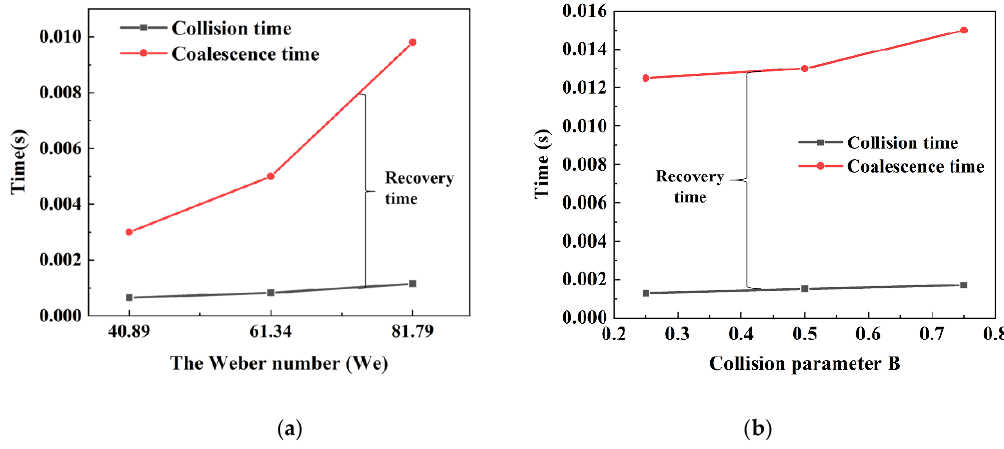
Figure 11. The collision time, coalescence time and recovery time evolution of water droplet collision in the oil phase: ( a ) different Weber numbers; ( b ) different collision parameters.